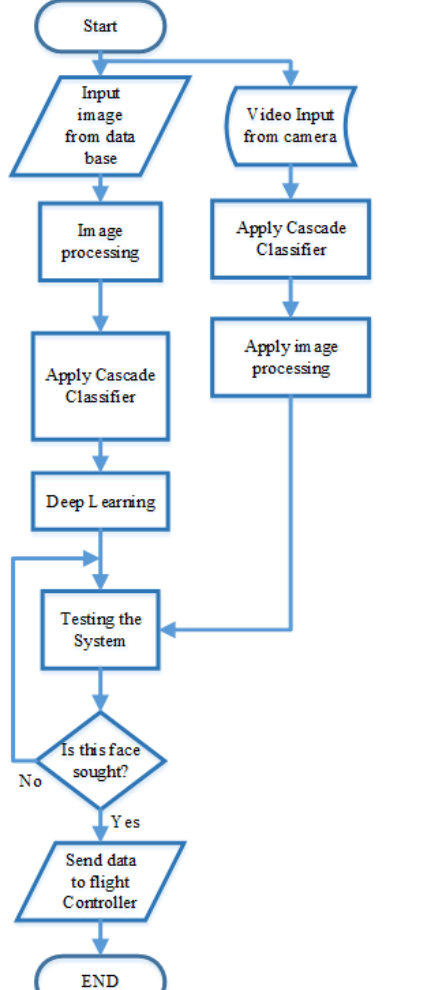
Fig. 1. Flowchart of the proposed system